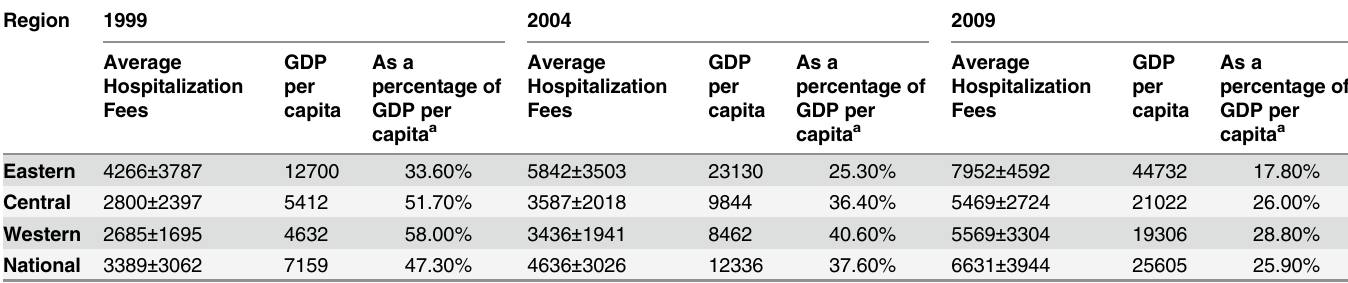
Table 2. Breakdown of hospitalization fees and GDP per capita, per region.